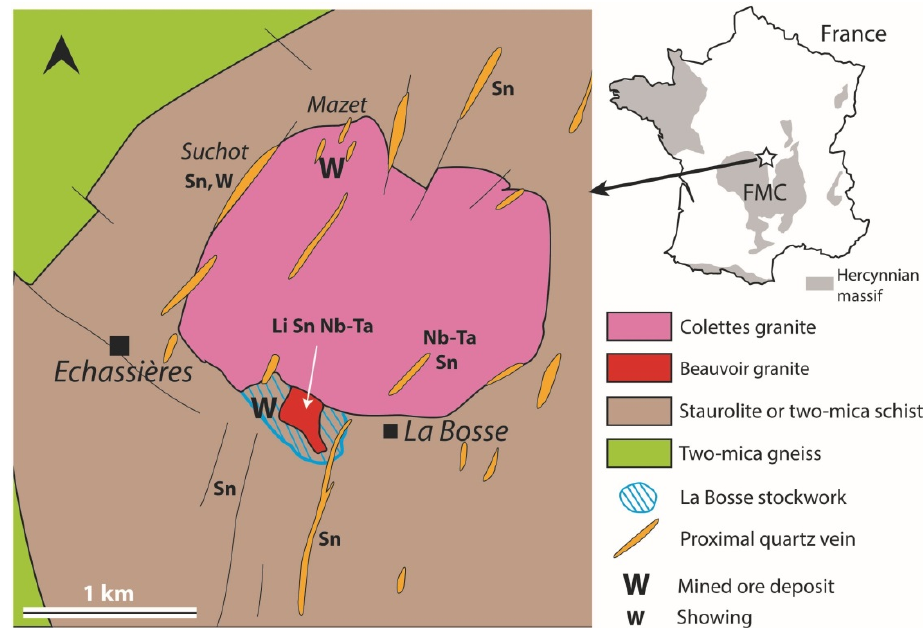
Figure 1. Geological map of the Echassières district in the French Massif Central (FMC) showing the principal mineralizations (modified after [24]). The town of Echassières is located at 46°11’01.72” N, 2°56’01.07” E. A schematic cross‐section centered on the Beauvoir granite is available in [24].